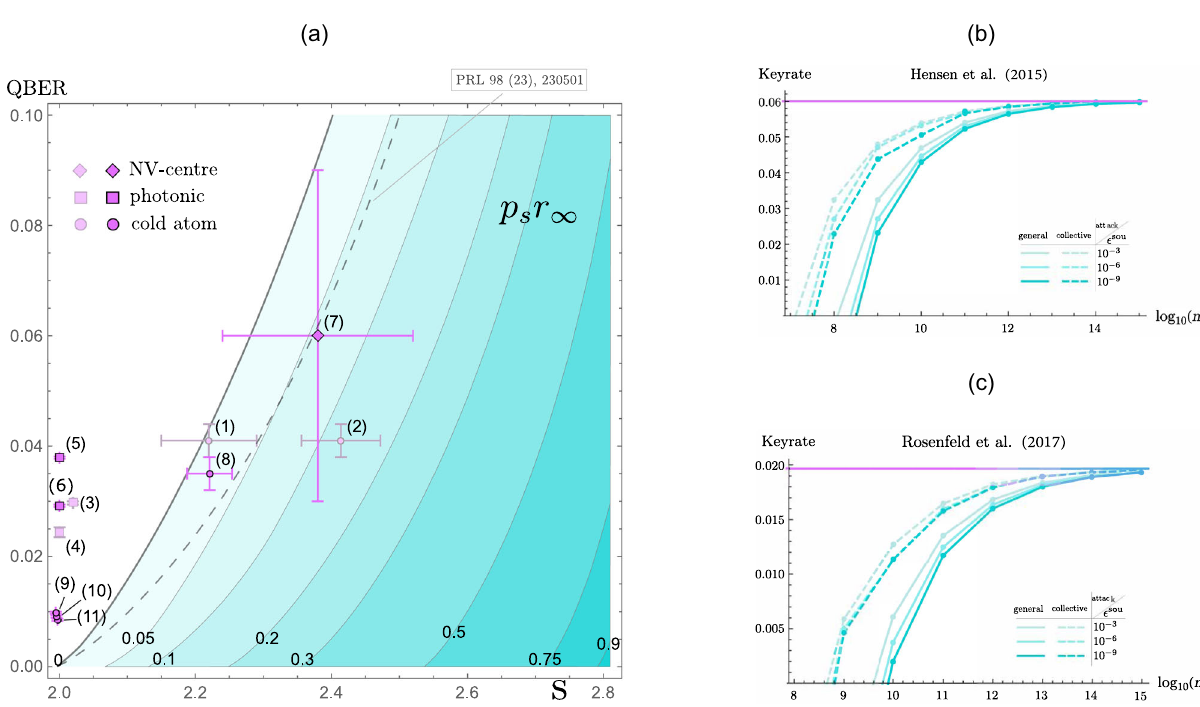
Fig. 3 Rates for existing experiments. The contour plot ( a ) illustrates the asymptotic key rate K ∞ = p s r ∞ as a function of S and QBER . We marked the location of recent experiments (see Table 1). Our DIQKD proposal suggests that now a positive asymptotic key rate of reasonable magnitude is possible for experiments (7, 8). The plots b , c show the fi nite-size key rates as a function of number of rounds, for the choice p = 1/2 (which appears optimal at these noise levels). These plots are for the estimated parameters in Murta et al. 18 for the Bell tests in ( b ) Hensen et al. 14 and ( c ) Rosenfeld et al. 17 , respectively. The solid curves show the results for general attacks, while the dashed curves show the results under the assumption of collective attacks. The different colours correspond to different soundness parameters ϵ sou (informally, a measure of how insecure the key is; see Supplementary Note 4) as listed in the inset legends, while the completeness parameter (the probability that the honest devices abort) is ϵ com = 10 − 2 in all cases. The horizontal line denotes the asymptotic key rate. Note that only experiments (5, 6, 7, 8, 9, 10, 11) are loophole-free Bell tests, closing both detection and locality loopholes. On the other hand, experiments (1, 2, 3, 4) did not close the locality